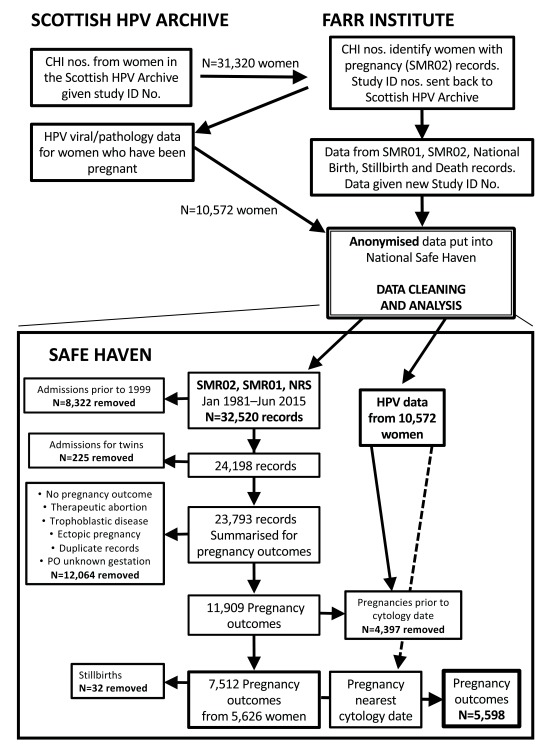
Summary of data-linkage and -cleaning processes.